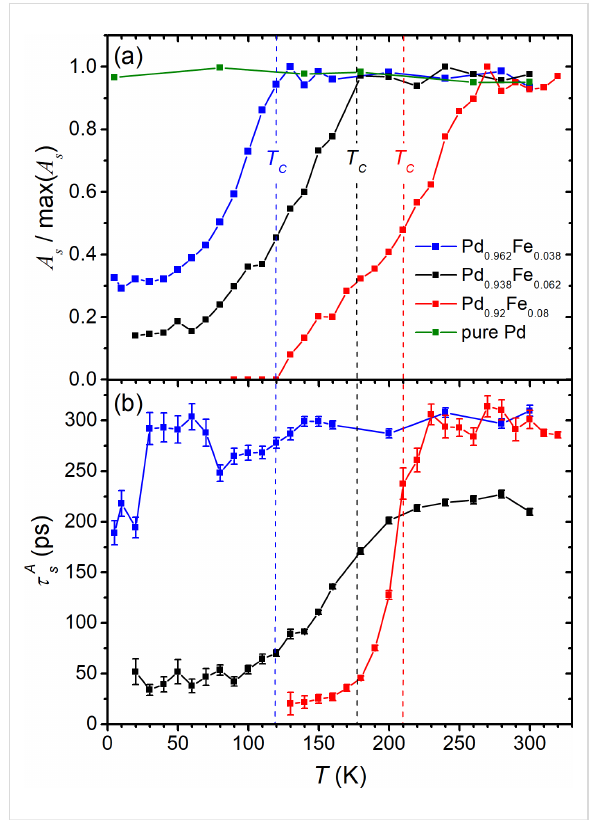
Figure 3: Temperature dependences of the amplitudes (a) and the life- times (b) of the slow relaxation components of the reflectivity tran- sients shown in Figure 1. In panel (a) the amplitude A s for each sam- ple is normalized to its magnitude at room temperature .